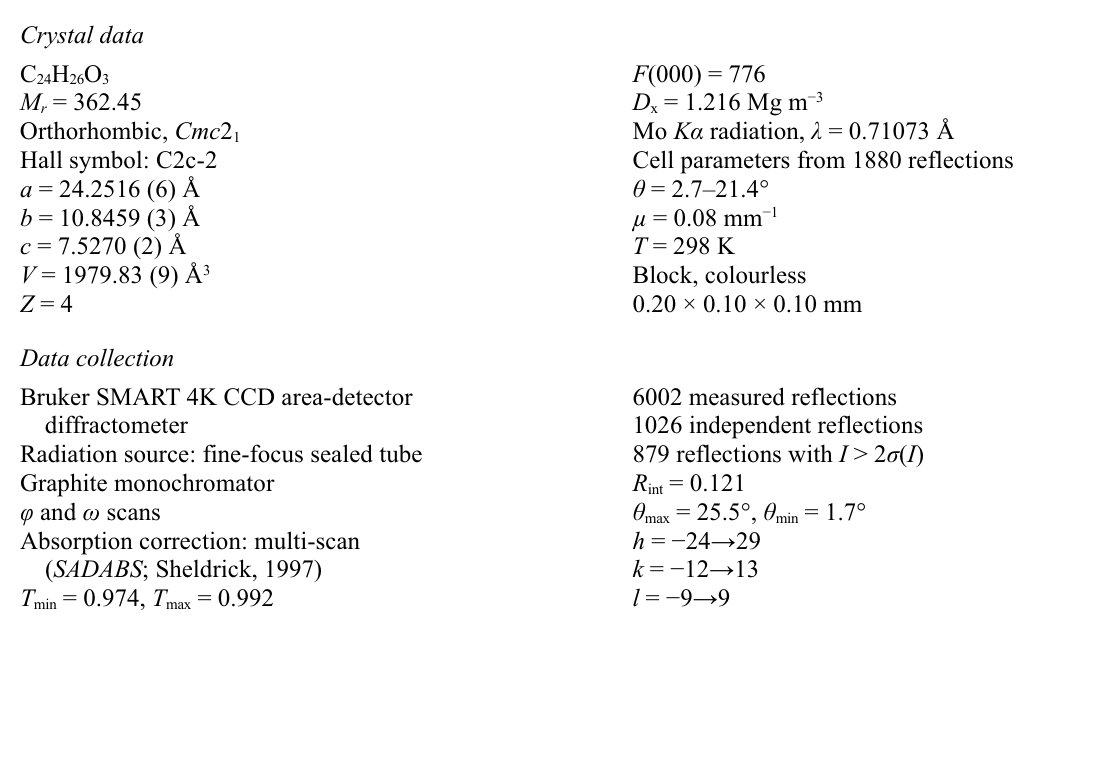
Figure 1 View of the molecule of (I) showing the atom-labelling scheme. Displacement ellipsoids are drawn at the 30% probability level. Symmetry code "a" represents the operation 1-x, y, z (2 E ,6 E